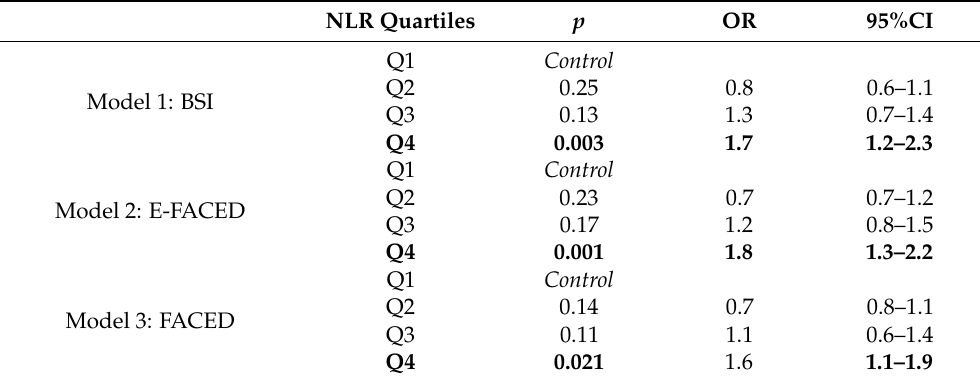
Table 4. Logistical regression to evaluate the risk of belonging to the group of exacerbator patients, according to the quartile, in the neutrophil-to-lymphocyte ratios in three models adjusted for gender and treatments, based on the severity scores for